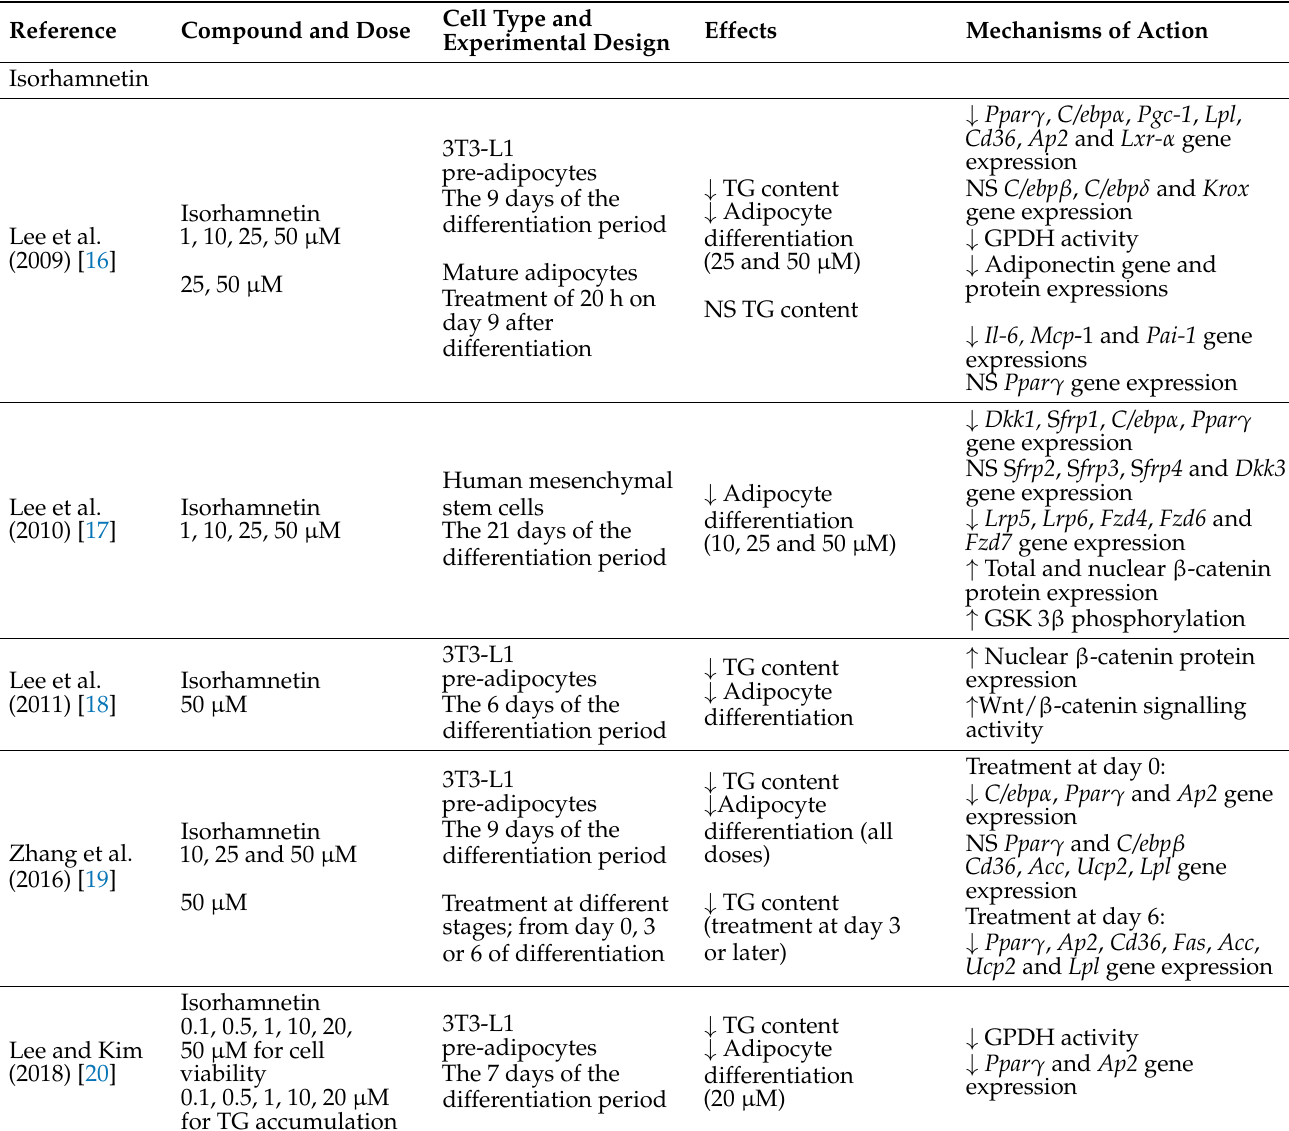
Table 2. Effects of isorhamnetin in cultured